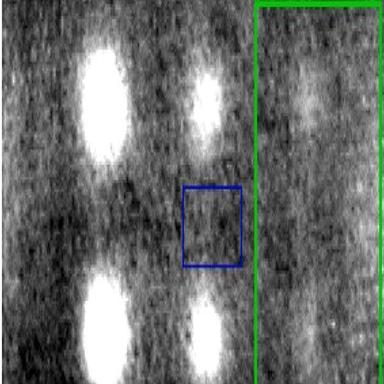
Comparison of excess images when the SNRs of defect C1 and C2 are close to 4 and 3 respectively.